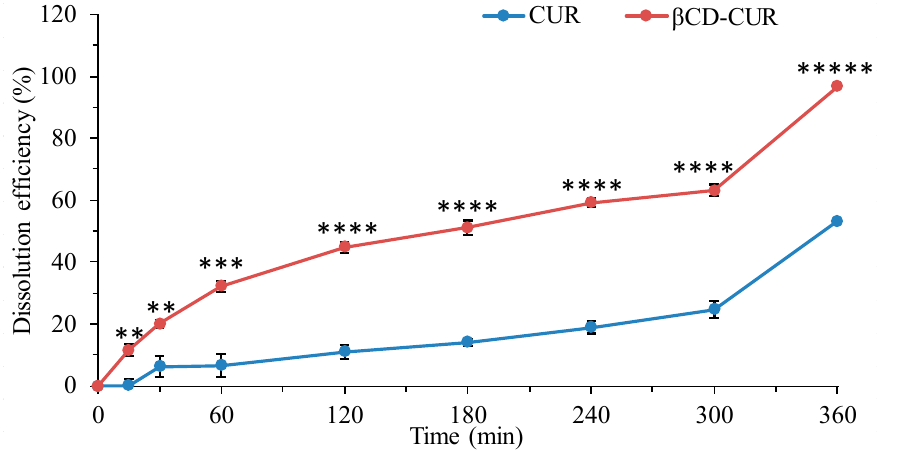
Figure 3. Time-dependent versus dissolution efficiency in two buffer media of pH 1.5 and pH 6.8 with 0.5% SLS. The release profile of CUR from the inclusion complex and pure CUR, ** p < 0.01, *** p < 0.001, **** p < 0.0001, and ***** p < 0.00001.